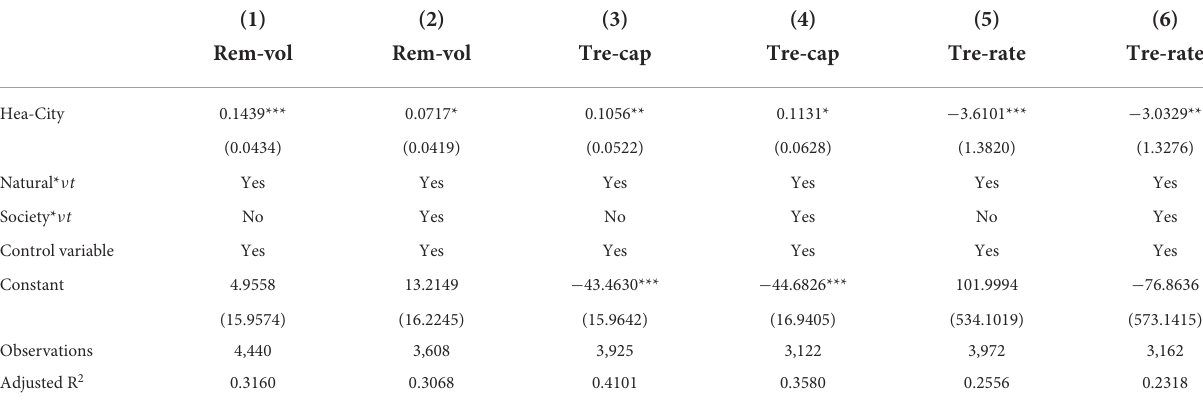
TABLE 5 Eliminating non-randomness of the policy.